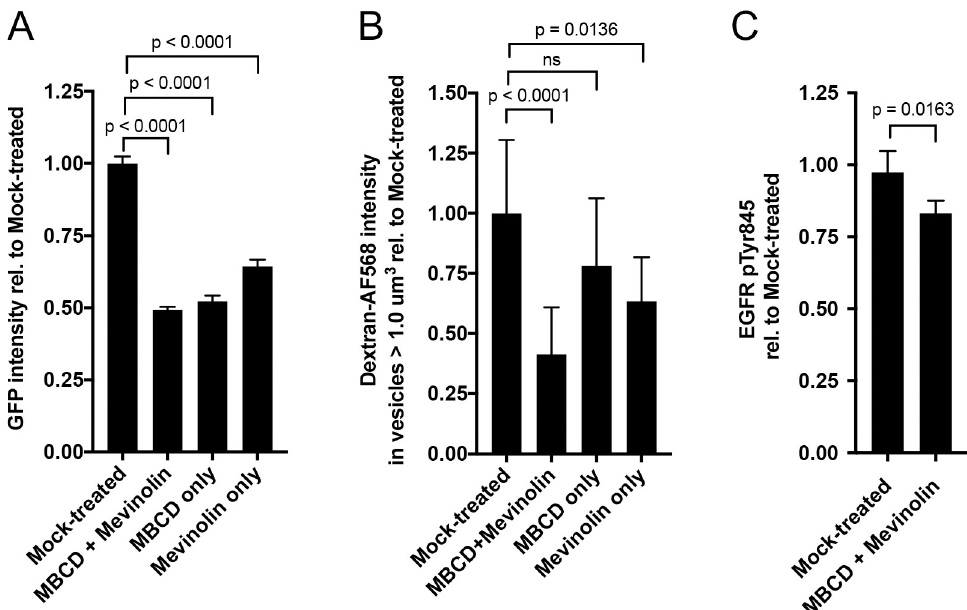
Fig 10. Effect of cholesterol depletion on RSV infection. A549 cells were cholesterol-depleted by treatment with methyl-beta-cyclodextrin (MBCD) and Mevinolin or each chemical separately. (A) RSV infection of cholesterol- depleted A549 cells. A549 cells were pre-treated for 5 h with the indicated cholesterol-depleting compounds and infected with RSV-GFP (MOI = 1 PFU/cell) with presence of the cholesterol-depleting compounds maintained. Viral GFP expression was quantified 17 h p.i. and reported relative to mock-treated infected cells. (B) Quantification of macropinocytosis in cholesterol-depleted RSV-infected A549 cells. A549 cells were pre-treated for 16 h with the indicated cholesterol-depleting compounds in the absence of serum and infected with RSV (MOI = 5 PFU/cell) in the presence of dextran-AF568. At 5 h p.i the cells were fixed with 5% PFA and nuclei were counterstained with DAPI. The total intensity of dextran-AF568 in vesicles larger than 1.0 μ m 3 was quantified (Materials and Methods) and reported relative to mock-treated infected cells. The statistical significance of the differences was determined by one-way analysis of variance with Tukey’s multiple-comparison post-test and p-values are indicated (ns, not significant) . (C) EGFR Tyr845 phosphorylation in cholesterol-depleted cells. A549 cells were treated with MBCD and Mevinolin for 16 h to deplete cholesterol from the plasma membrane. Cells were infected with wt RSV (MOI = 5 PFU/cell) and the phosphorylation of EGFR Tyr845 was quantified by an EGFR phosphorylation antibody array, as described in Fig 8. The level of pTyr845 was reported relative to mock-treated infected cells. The statistical significance of difference was determined by a two-tailed unpaired t-test.